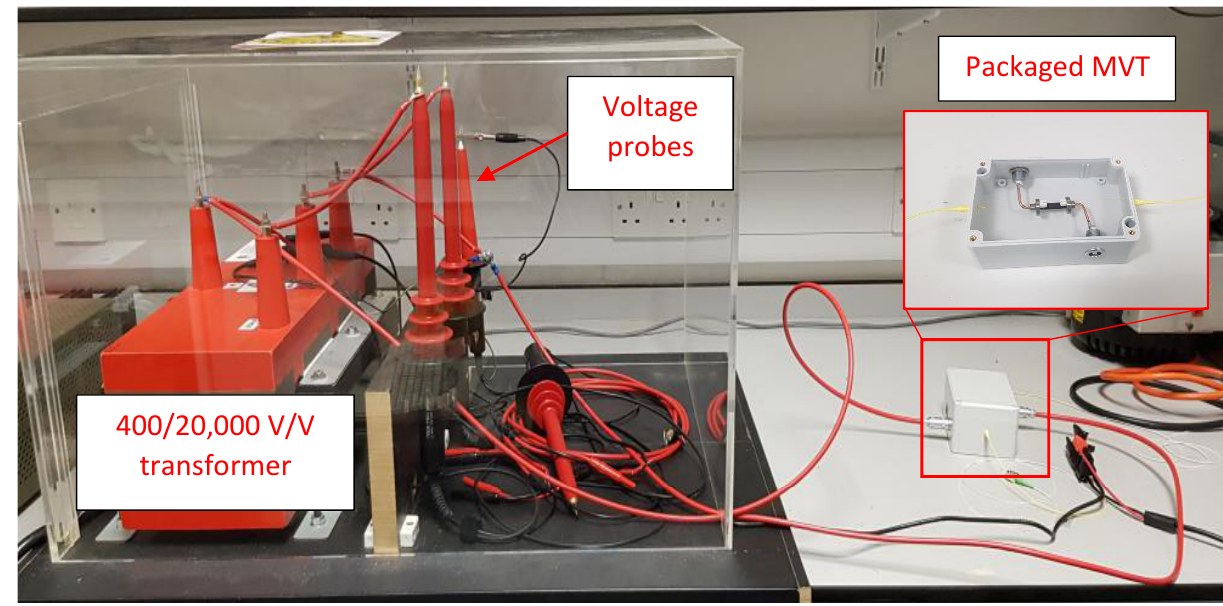
Figure 4. The MVT module connected to a single phase of a 20 kV three-phase transformer. The MVT module was energized from a single phase of a 20 kV three-phase